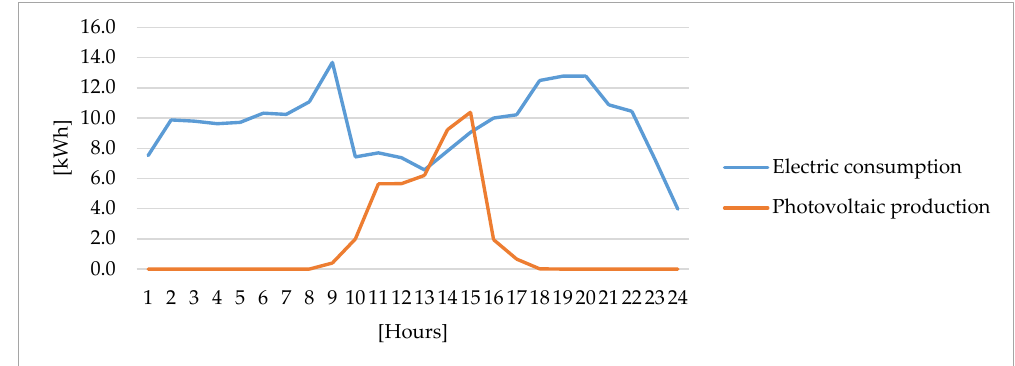
Figure 4. Typical summer day load profile.